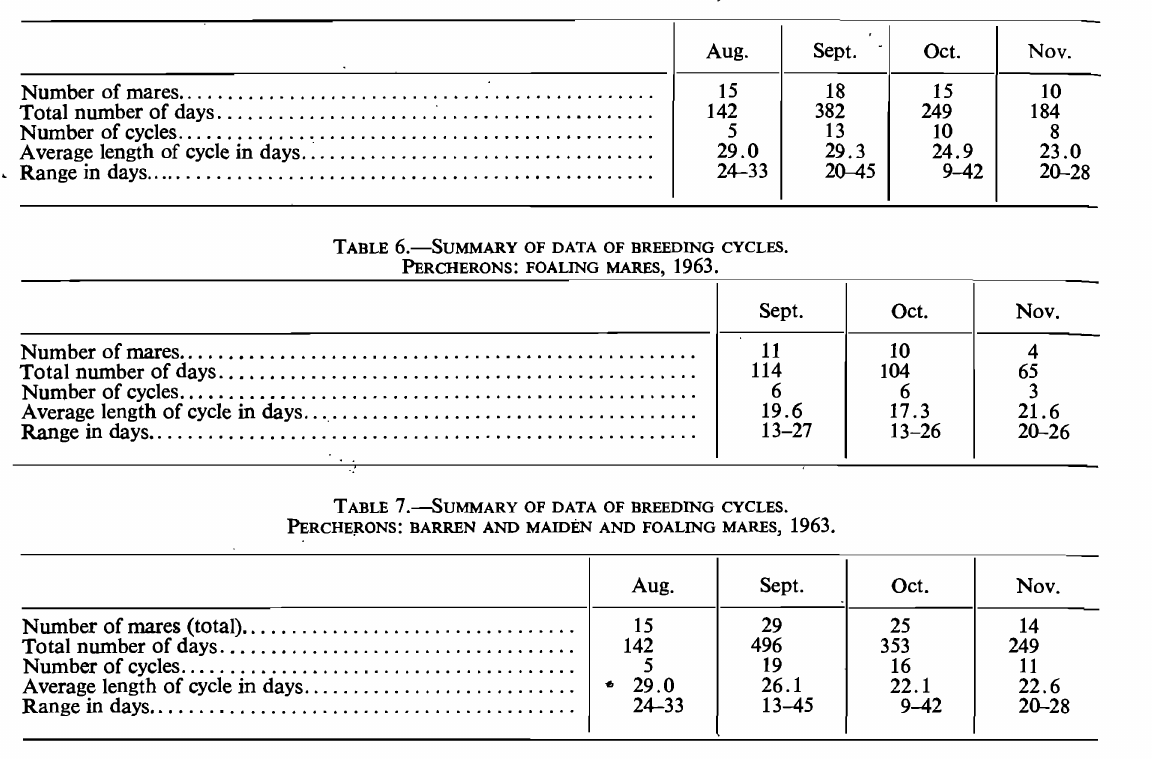
TABLE 5.-SUMMARY OF DATA OF BREEDING CYCLE. PERCHERONS: MAIDEN AND BARREN MARES, 1963.